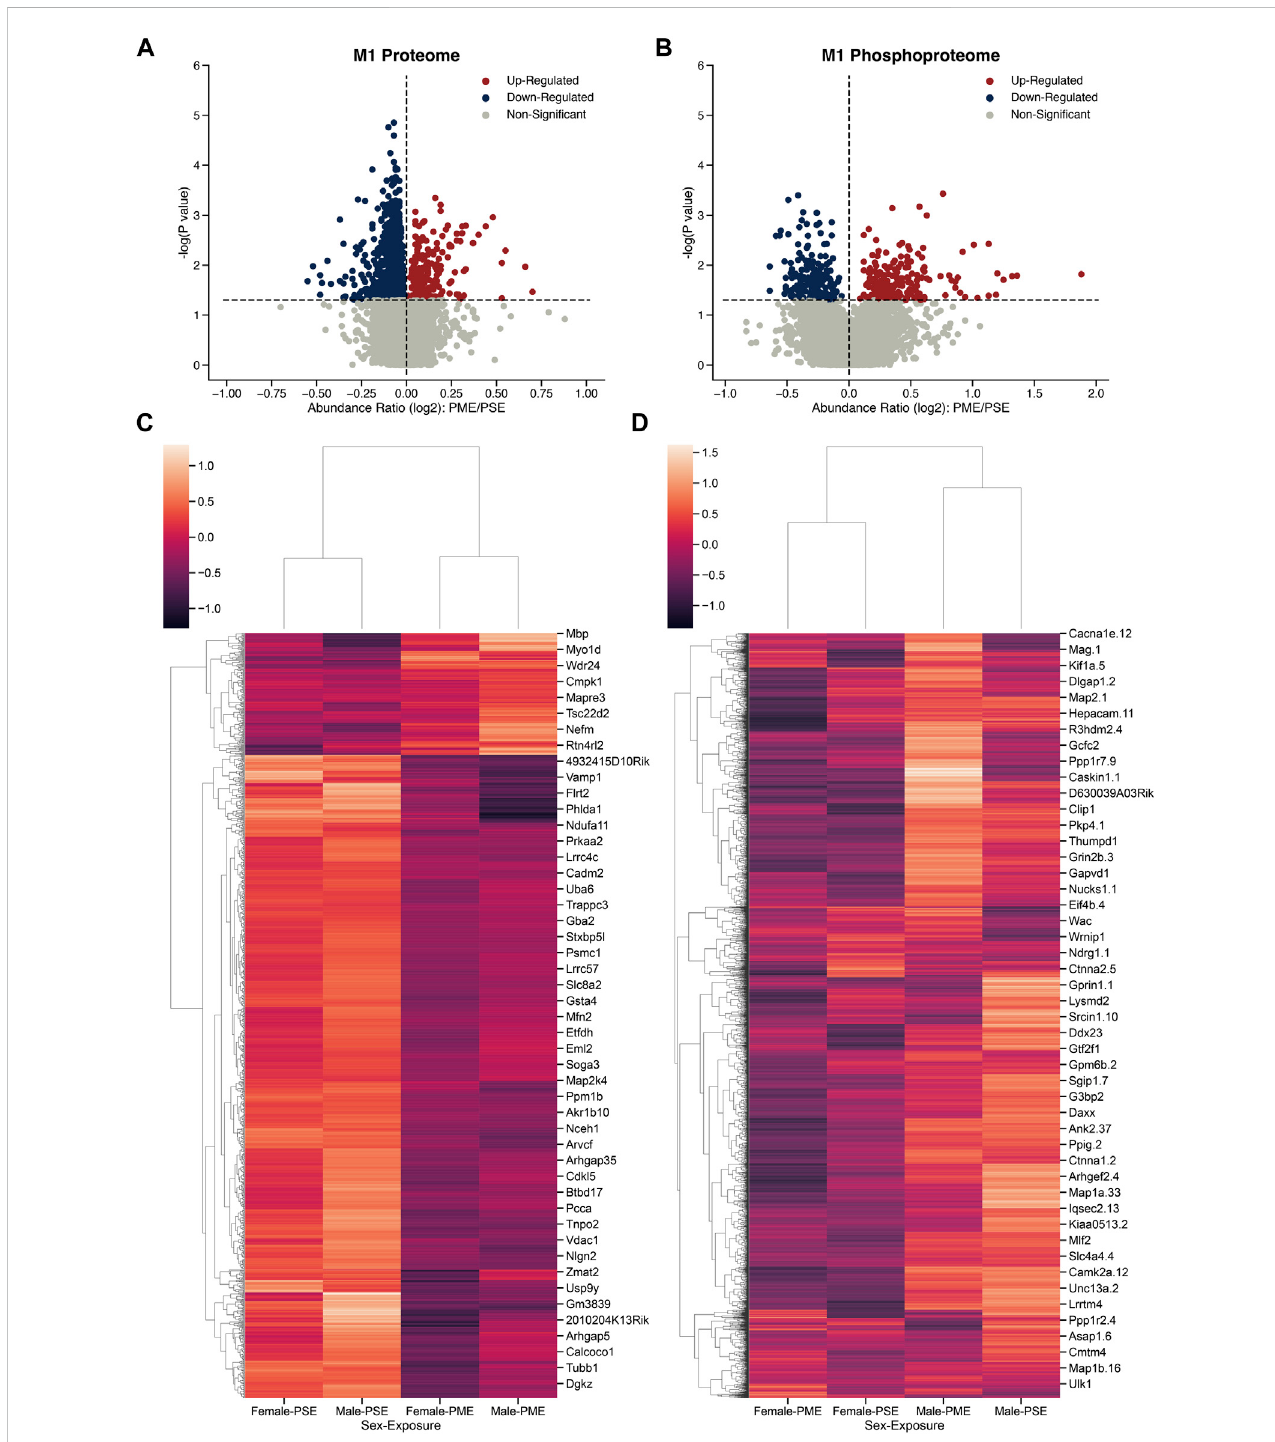
FIGURE 1 Differential protein and phosphopeptide expression in the primary motor cortex (M1) of prenatal methadone exposed offspring. Volcano plots for the differential proteome (A) and phosphoproteome (B) with blue circles representing individual proteins/phosphopeptides decreased in PME vs. PSE and red circlesrepresentingindividualproteins/phosphopeptidesincreasedinPMEvs.PSEwhichreachthelevelofsigni fi cance.Clusterplotsofdifferentiallyabundant proteins (C) and phosphopeptides (D) with example GeneIDs (n = 8 (4M:4 F) PME, 8 PSE (4M:4